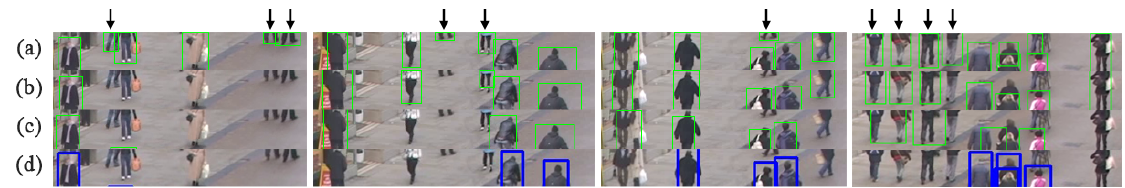
Figure 12. Human detection with partial visibility (missing upper body parts). ( a ) DeepSOCIAL ( b ) YOLOv4 trained on MS-COCO, ( c ) YOLOv3 ( d ) Ground-truth annotations from the Oxford Town Centre (OTC) dataset.